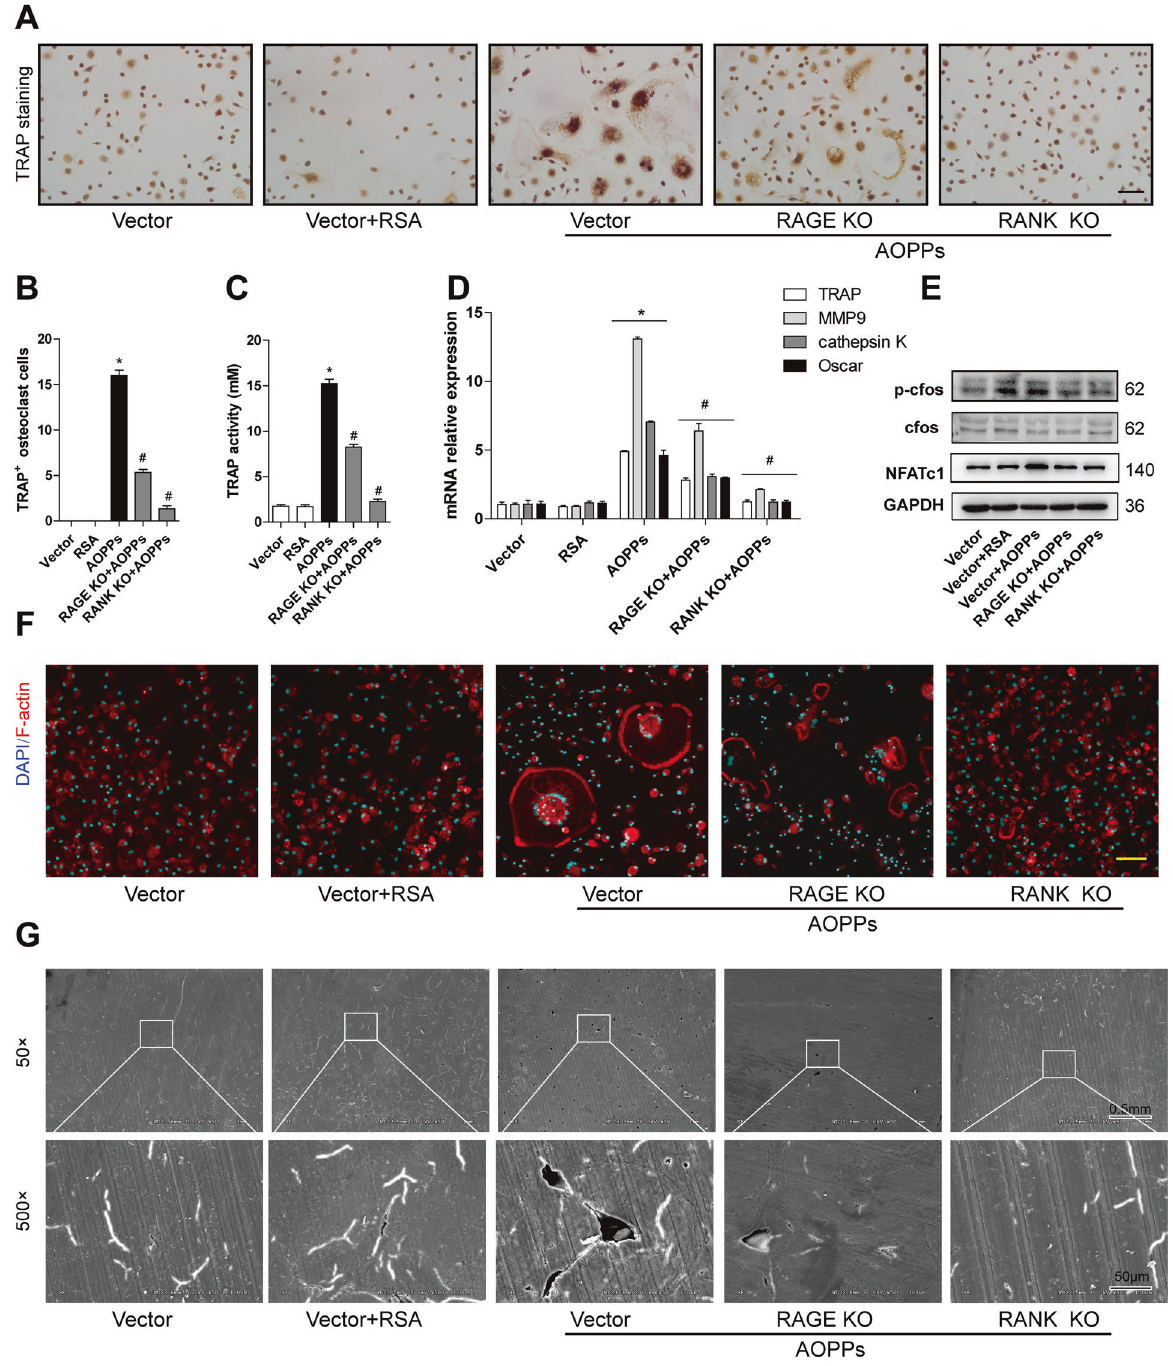
Fig. 6 AOPPs induced osteoclastogenesis by RANK and RAGE signaling. A , B Knockdown of RANK or RAGE suppressed the formation of TRAP positive cells induced by AOPPs. Scale bars = 200 μ m. C Knockdown of RANK or RAGE decreased the TRAP activity, D Knockdown of RANK or RAGE inhibited gene expression of TRAP, MMP9, cathepsin K, and Oscar. E Knockdown of RANK or RAGE inhibited the expression of NFATc1 and phosphorylation of c-fos, F Knockdown of RANK or RAGE inhibited the formation of F-actin rings induced by AOPPs. Scale bars